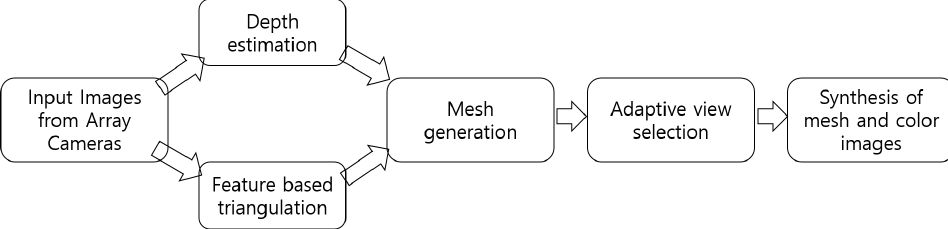
Figure 1. Flow diagram of generating an extended 3D view using a set of images using array